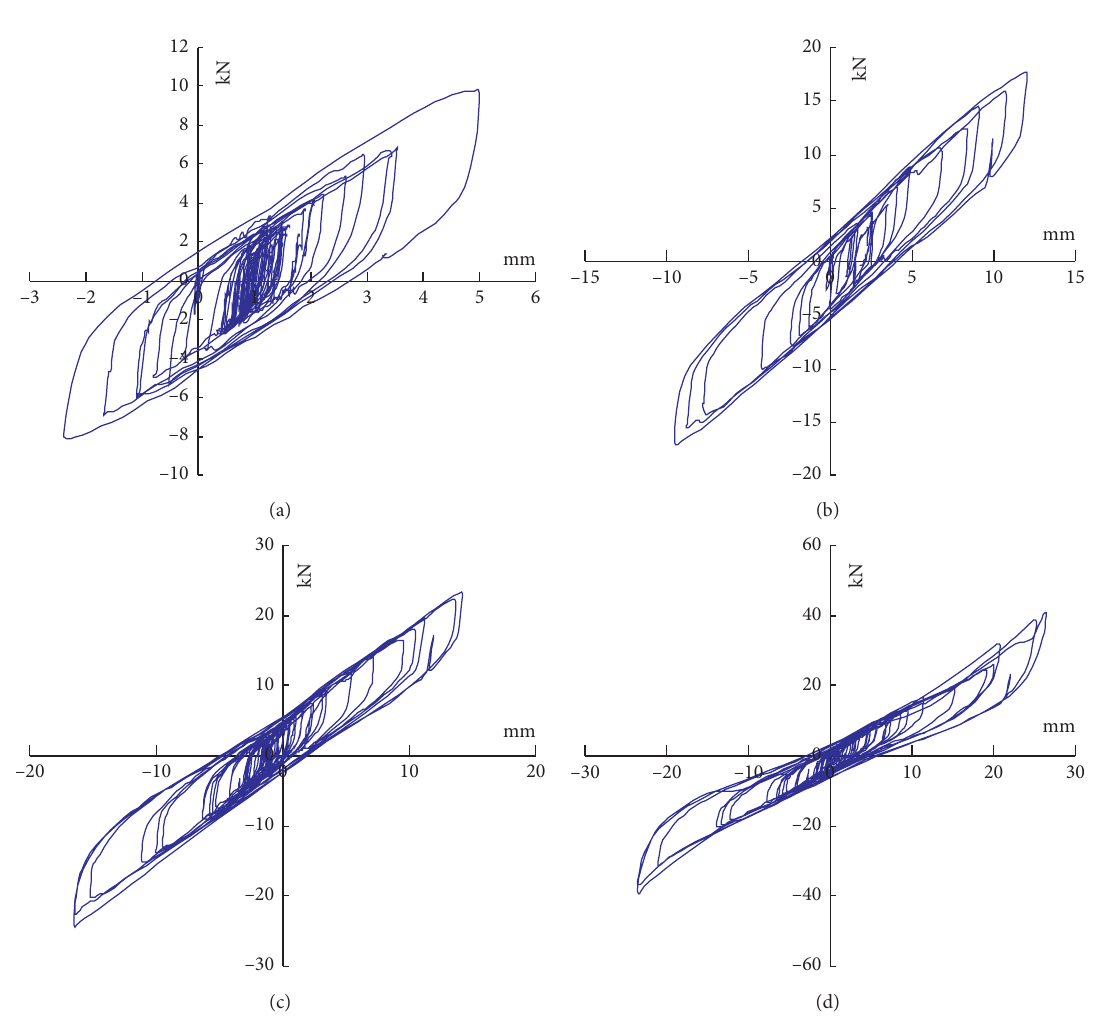
Figure 9: MLQT-4 (800 gal) hysteretic curve: (a) hysteresis curve of 90mm LRB wall; (b) maximum hysteresis loop area.